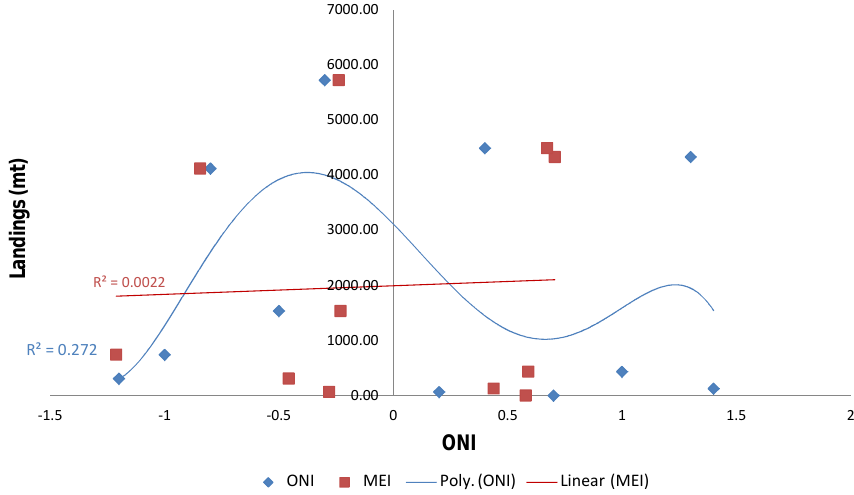
Figure 11. Chuhueco Q 4 (trimester, October–December) vs. the ONI ( n = 5) and MEI Q 4 (October–December), 2000–2012.